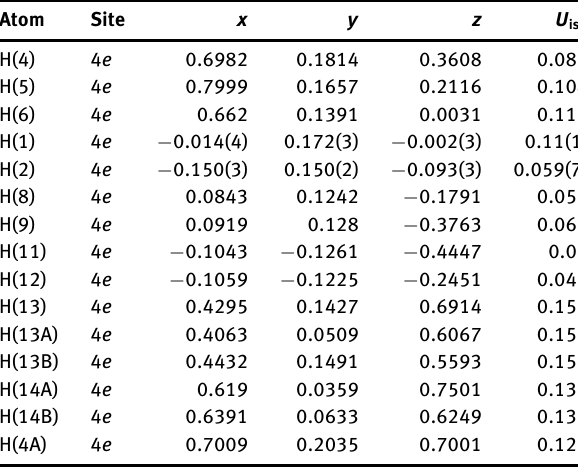
Table 2: Fractional atomic coordinates and isotropic or equivalent isotropic displacement parameters (Å 2